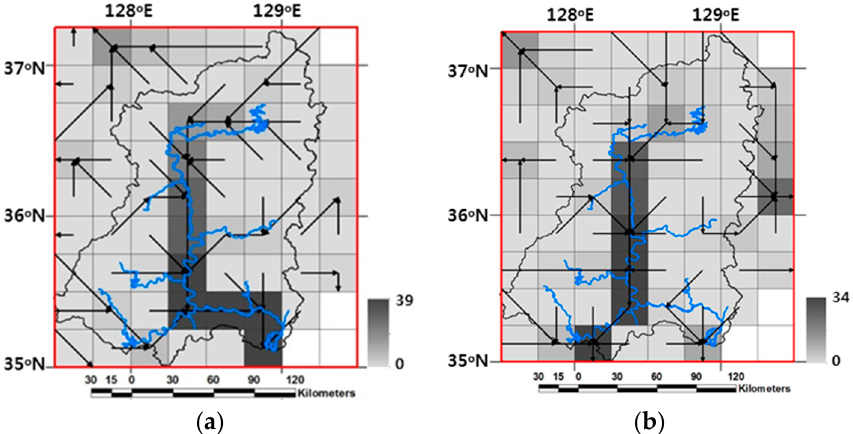
Figure 4. Comparison of lateral flow surface boundary conditions for the CoLM+LF flow direction (arrows) and flow accumulation (grey-black pixels) ( a ) from our own upscaling method; and ( b ) from ArcGIS eight direction method on 30-km computational grids with overlays of the main stream networks (blue lines) and the watershed boundary (black polygon) over the study domain.